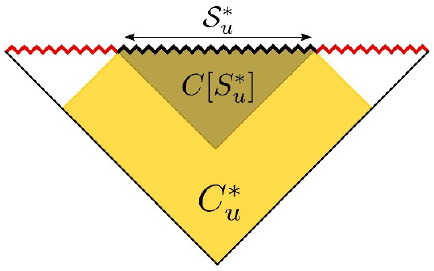
Figure 6 . The difference between C ∗ u and C [ S ∗ u ] as determined by the different domains of